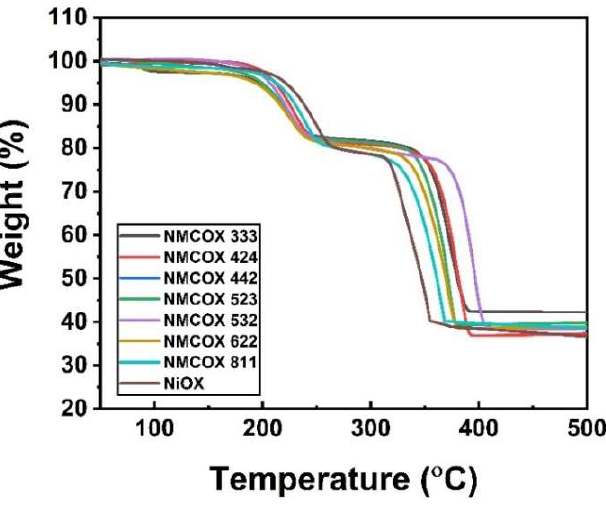
Figure 2 . FTIR spectra of the oxalate precursor; ( a ) MnOX, ( b ) CoOX, ( c ) NMCOX 333, ( d ) NMCOX 424, ( e ) NMCOX 442, ( f ) NMCOX 523, ( g ) NMCOX 532, ( h ) NMCOX 622, ( i ) NMCOX 811, and ( j ) NiOX.